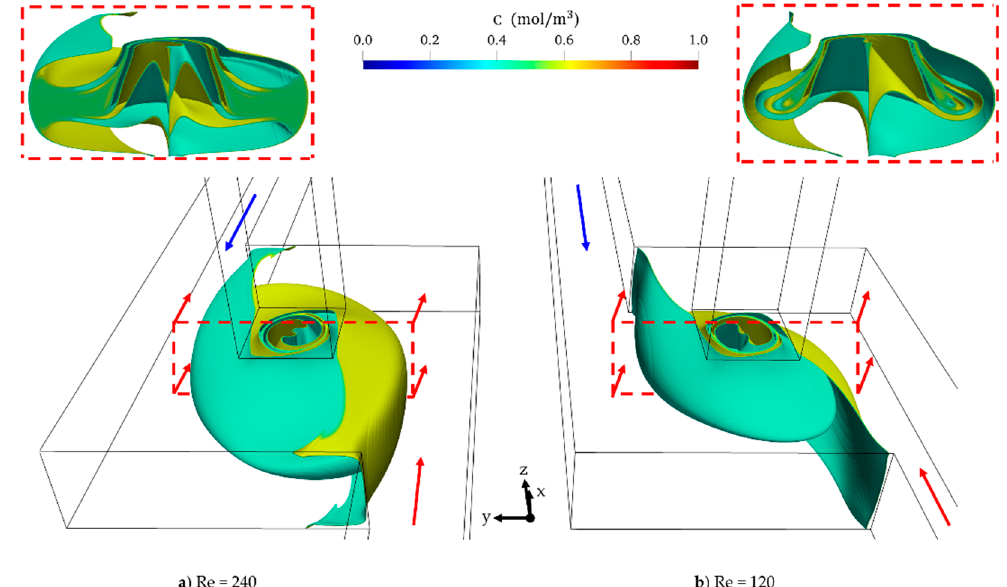
Figure 13. Flow profile and multi-layer mixing structure in the mixing box of two-inlet design: ( a ) Re = 240 and ( b ) Re = 120. Images show scalar transport at M1 mesh level.